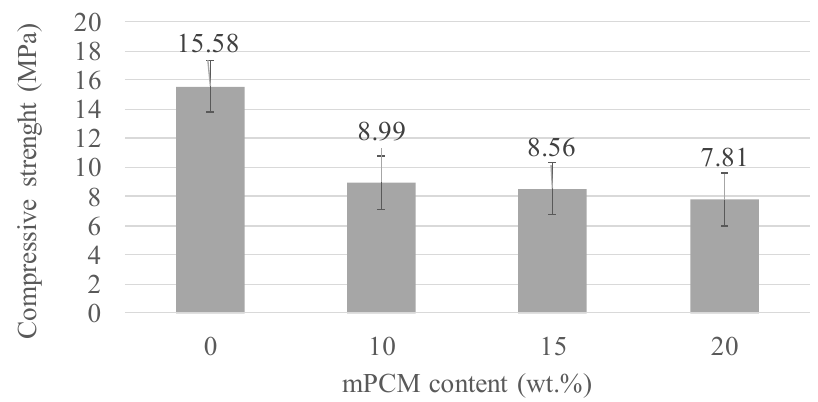
ff erent alkali-activated cement (AAC)